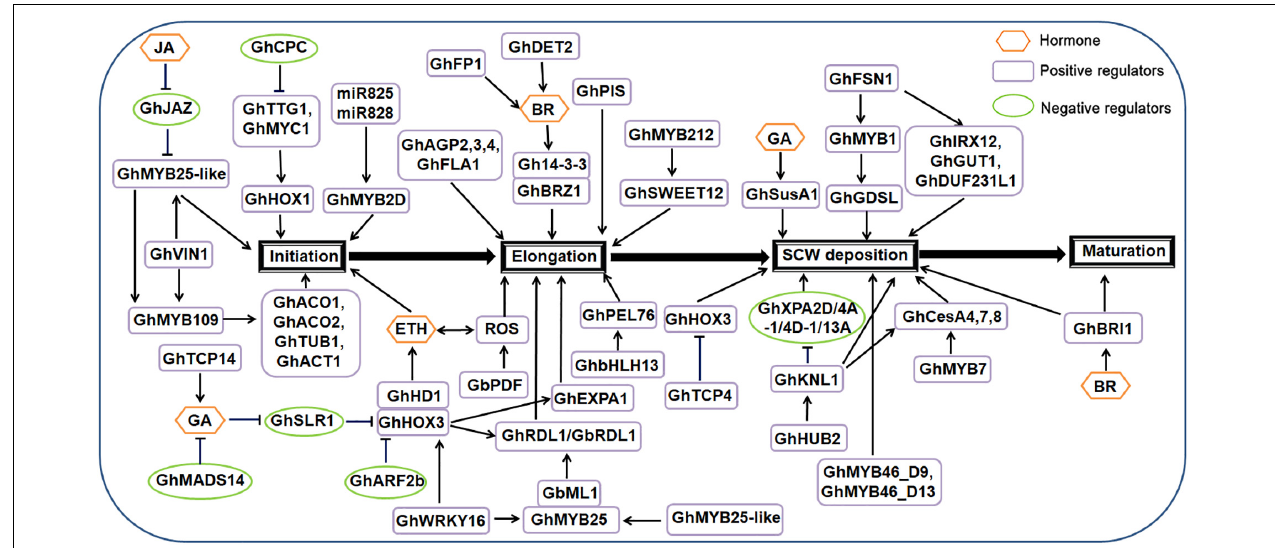
FIGURE 2 | Regulatory network model for trichome (fiber) development in